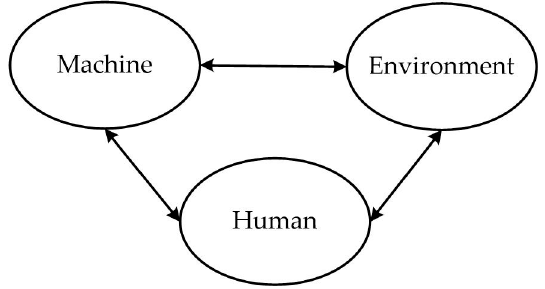
Figure 1. A human–machine–environment system [36].